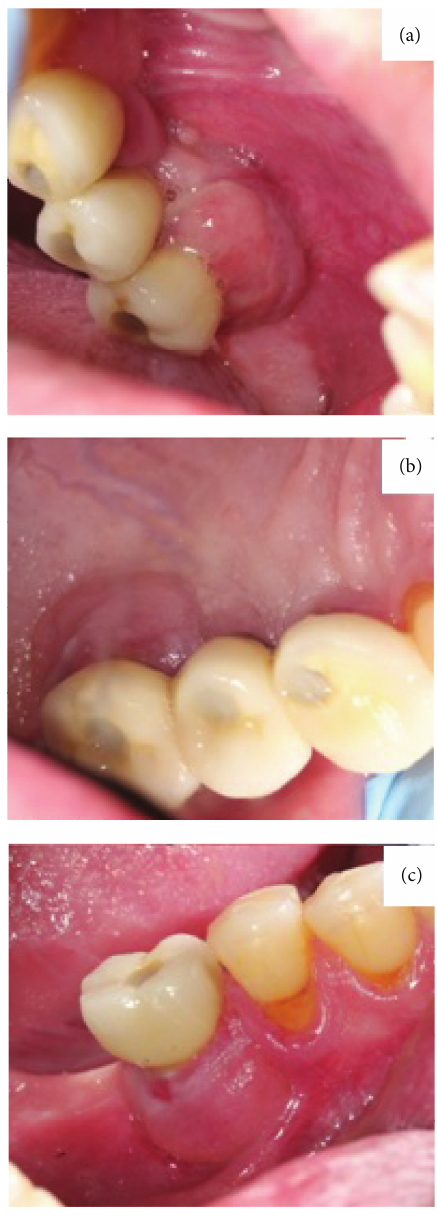
Figure 3: (a) 12-month postexcision follow-up of the lesion in 16 and 17 area. (b) Palatal view of the 12-month postexcision follow-up of the lesion in 16 and 17. (c) 12 month postexcision follow-up of the lesion in